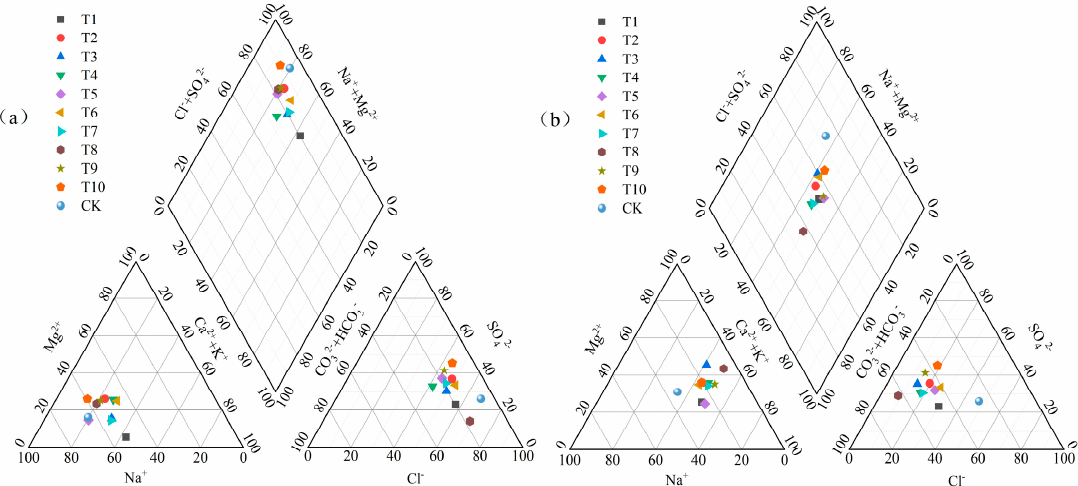
Figure 8. Piper plots of soil salt ions under different magnetized water irrigation treatments. The Piper diagram shows the composition and evolution characteristics of the main ions in the soil solution irrigated with different magnetized water treatments [23–25]. ( a ) the initial percentage ratio of soil salt ion groups under different treatments before magnetized water irrigation; ( b ) the percentage ratio of soil salt ion groups at the end of the growth period of jujube under different magnetized water irrigation